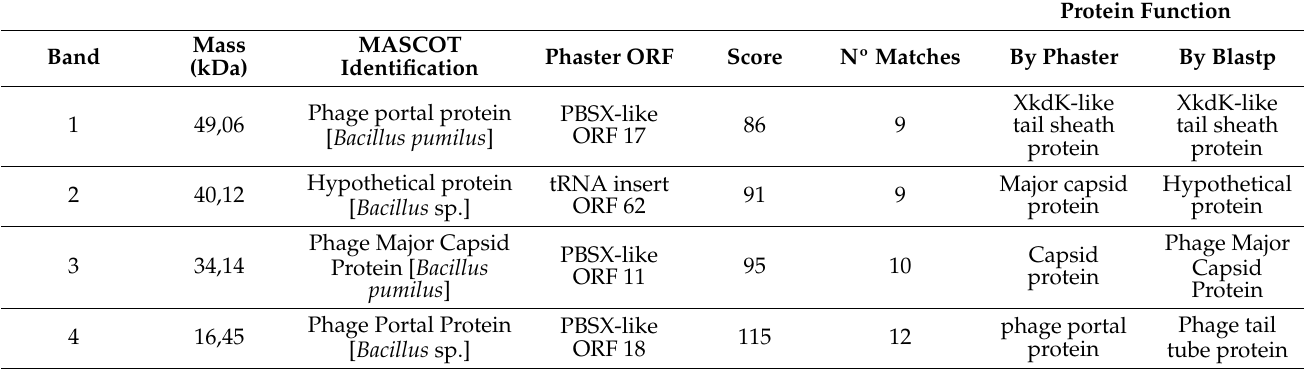
Table 4. Proteins identified by